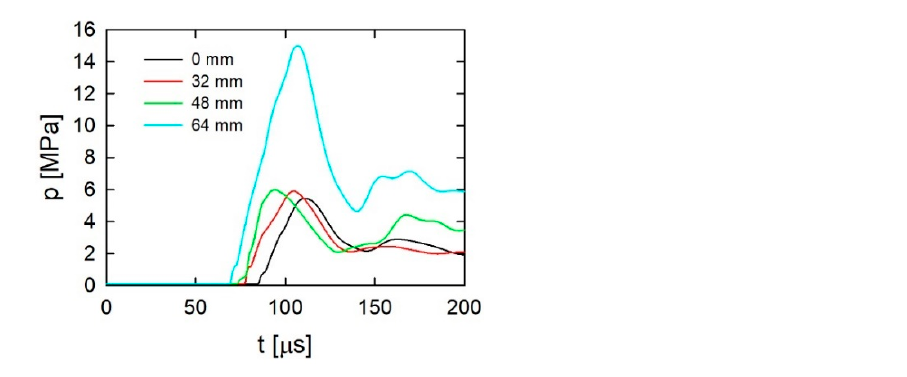
Figure 17. The changes in time of the pressure acting on the end of the chamber: black line: the results of measurements, red line: the results of calculations.